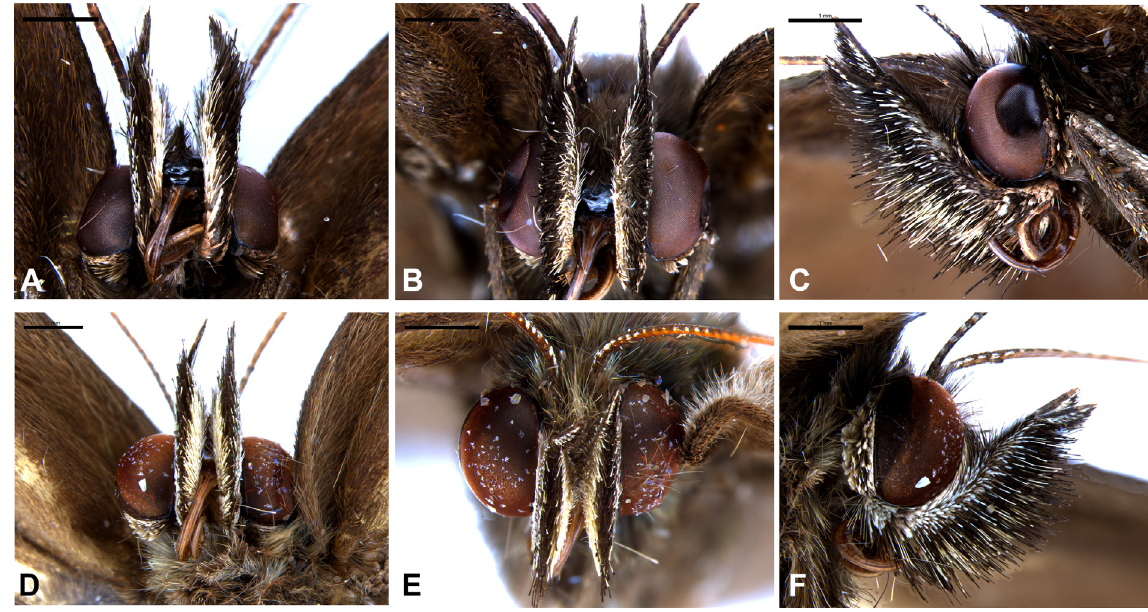
Fig. 10. Head morphology. A–C . Zischkaia pacarus (Godart, 1824) (DZ 36.728). A . Ventral view. B . Frontal view. C . Lateral view. D–F . Z. saundersii (Butler, 1867) (DZ 36.029). D . Ventral view. E . Frontal view. C . Lateral view